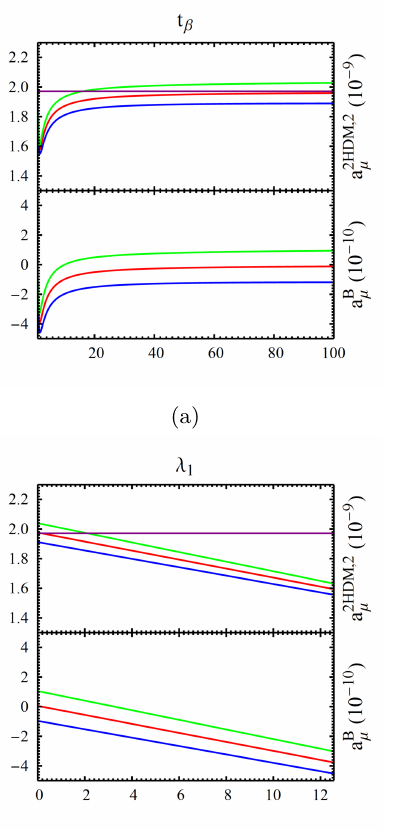
Figure 1 . Revised version of figure 10. Plots showing the behavior of a 2HDM , 2 red/blue/green line is for η = 0 / 0 . 1 / – 0 . 1 . t β varies for (a) and (b), and λ 1 for (c) and (d). We consider the representative mass parameter point in eq. (4.3). λ 1 = 4 π for (a) and (b). We employ t β = 2 and t β = 100 for (c) and (d)